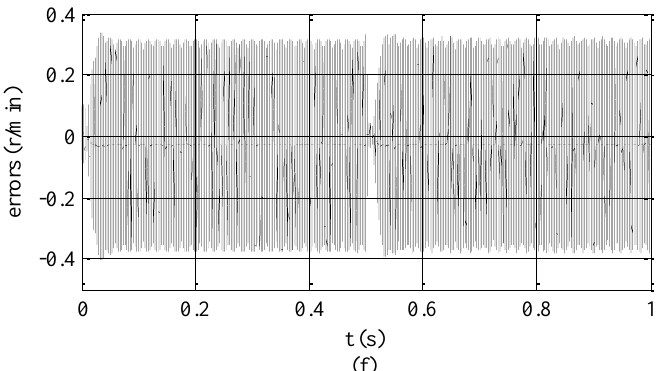
Figure 8. Waveforms of rotor speed: ( a ) actual rotor speed with speed changes; ( b ) estimated rotor speed with speed changes; ( c ) errors between actual rotor speed and estimated rotor speed with speed changes; ( d ) actual rotor speed with torque changes; ( e ) estimated rotor speed with torque changes; ( f ) errors between actual rotor speed and estimated rotor speed with torque